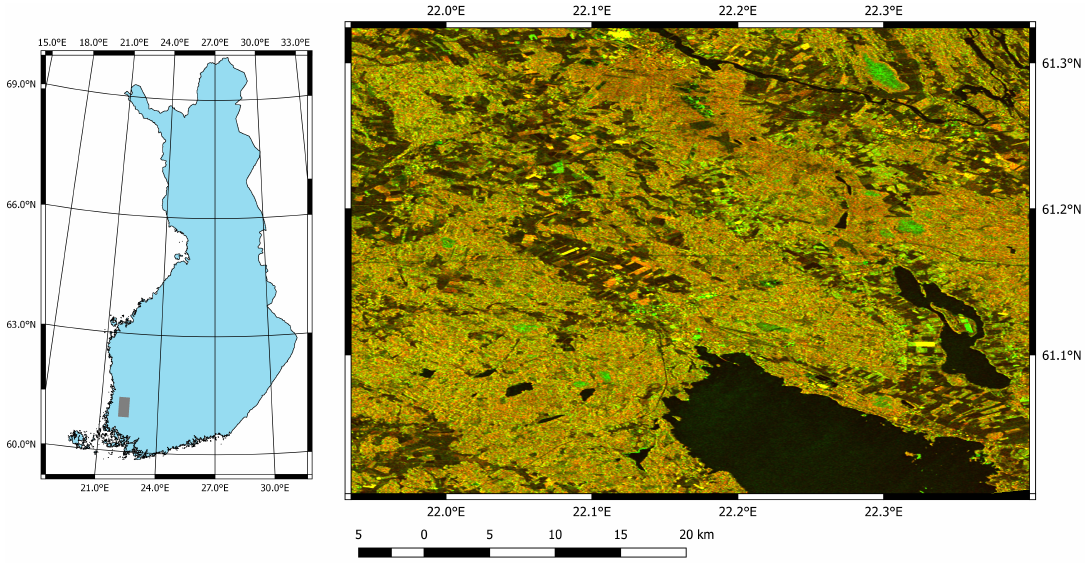
Figure 1. Study area location in the southwestern part of